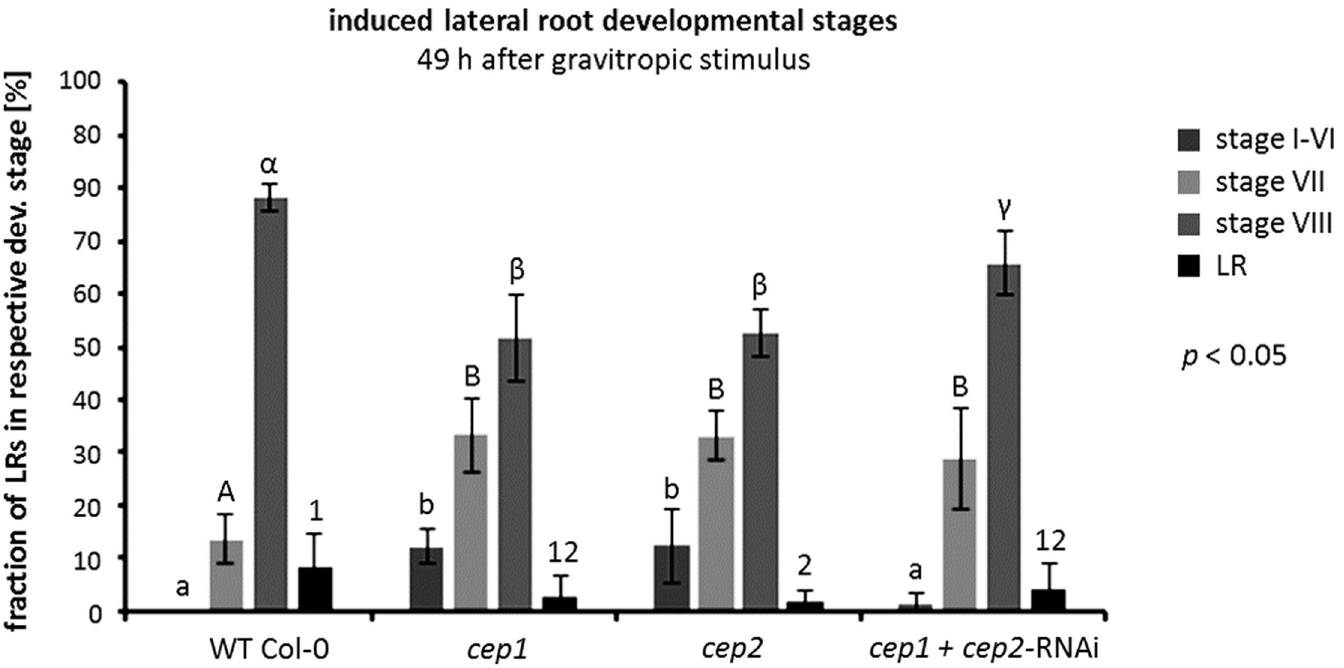
Fig 12. Loss of function of CEP1 or CEP2 retards lateral root (LR) emergence. The quantitative evaluation of the eight stages (roman numbers, see S5 Fig) of LR primordium development in the roots of 10 day old cep1 ko, cep2 ko, and cep1/2 double ko/kd mutants ( cep1 + cep2- RNAi) were analyzed and compared to WT plants 49 hours after initiating the LR formation by “root bending”, when most of the WT plant LR primordia just reached the epidermis (stage VII). Single loss of function results in the strongest quantitative phenotype in retardation of LR development as compared to WT. Double loss of function does not result in an enhanced retardation of LR emergence. Columns represent the respective means expressed as percentage of LR primordia in the respective developmental stage in four independent experiments (biological replica): WT (15, 20, 18, or 20 plants per biological replica), cep1 ko (26, 24, 30, or 27 plants), cep2 ko (25, 29, 26, or 28 plants), cep1/2 double ko/kd mutants ( cep1 + cep2- RNAi) (21, 24, 22, or 26 plants). Columns marked with different letters indicate statistically different groups according to the ANOVA-and Duncan test ( p < 0.05).